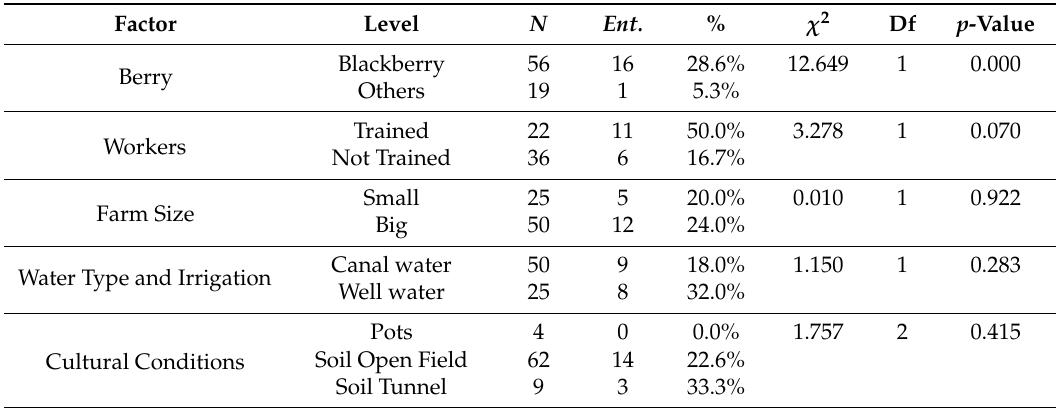
Table 4. Association between the presence of Enterobacteriaceae (Ent.) and farm characteristics estimated by a chi-square test. A p -value < 0.05 is considered to be statistically